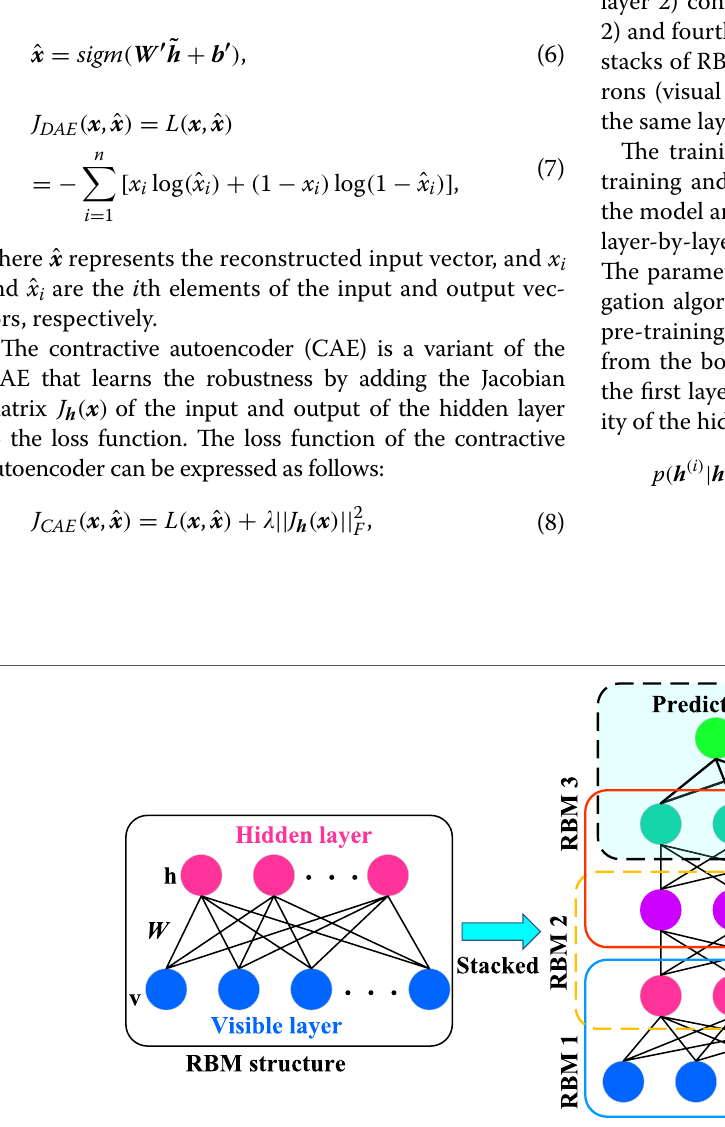
Figure 2 Structure of DBN